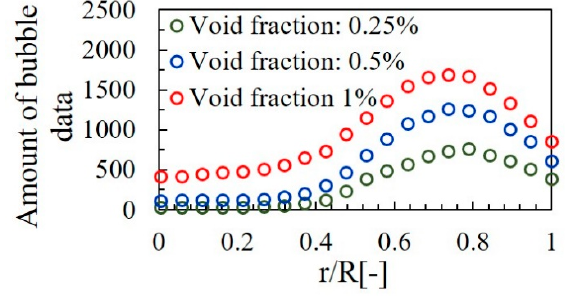
Figure 20. Velocity profile of bubble and liquid at a different void fraction.